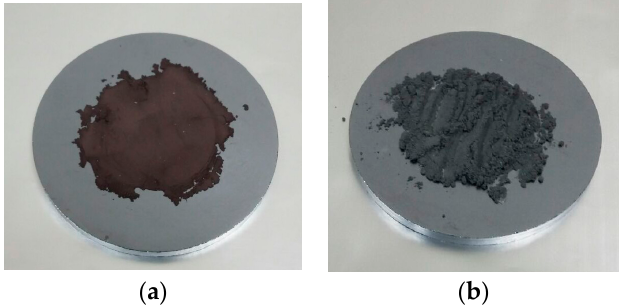
Figure 6. MoO 3 reduction products: R-1 hygroscopic powder rich of MoO 2 ( a ) and R-2 almost only Mo metallic ( b ).